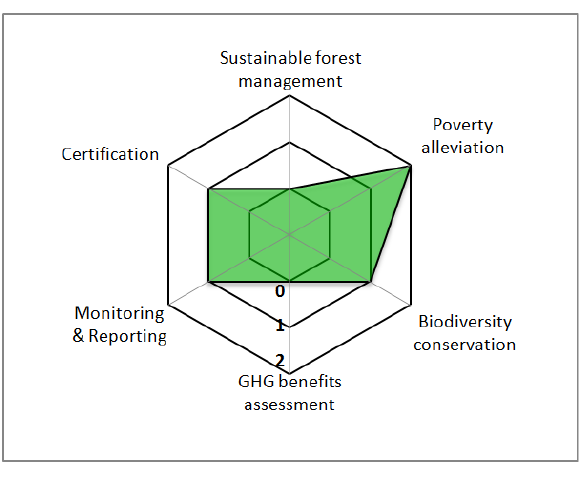
Figure 5. Summary of SOCIALCARBON Standard.